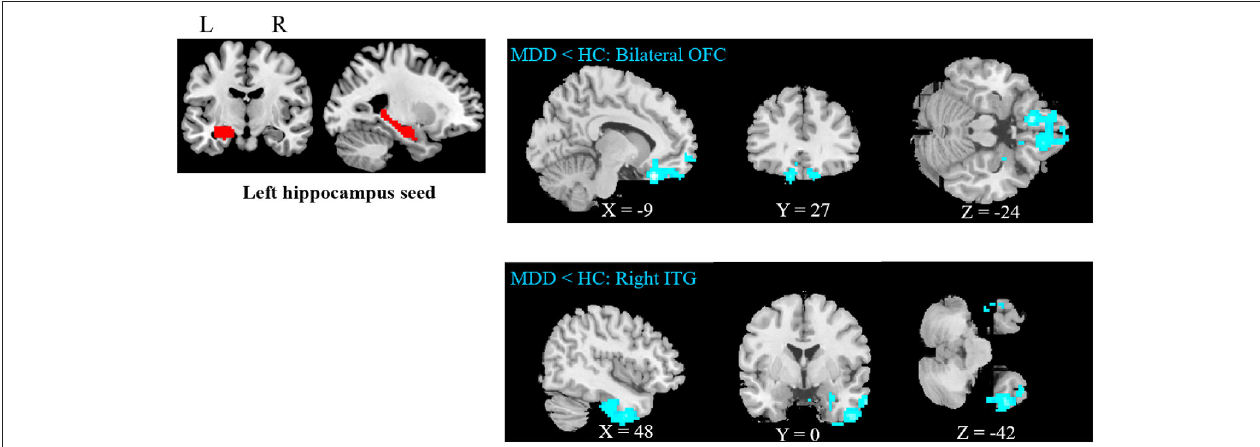
FIGURE 1 | Abnormal resting-state FC between hippocampus and regions. The OFC and ITG regions showed decreased FC in the adolescent depression group. The results were obtained using a seed-based analysis method with the left hippocampus as the seed (OFC, orbital frontal cortex; ITG, inferior temporal gyrus; HC, healthy control; MDD, major depressive